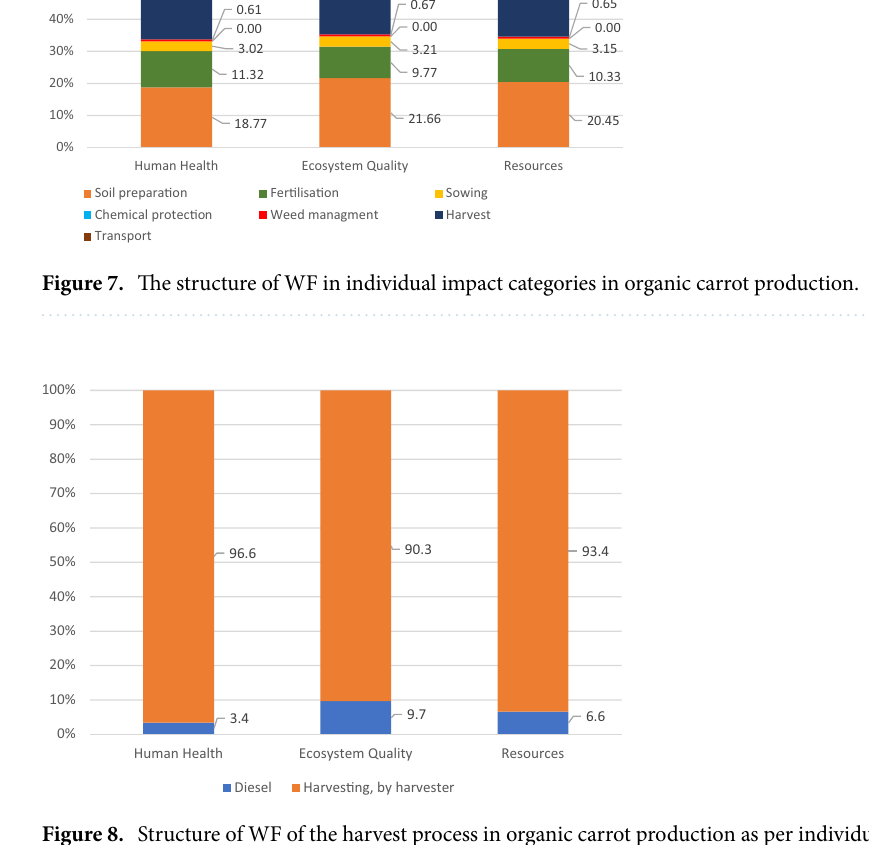
Figure 8. Structure of WF of the harvest process in organic carrot production as per individual impact